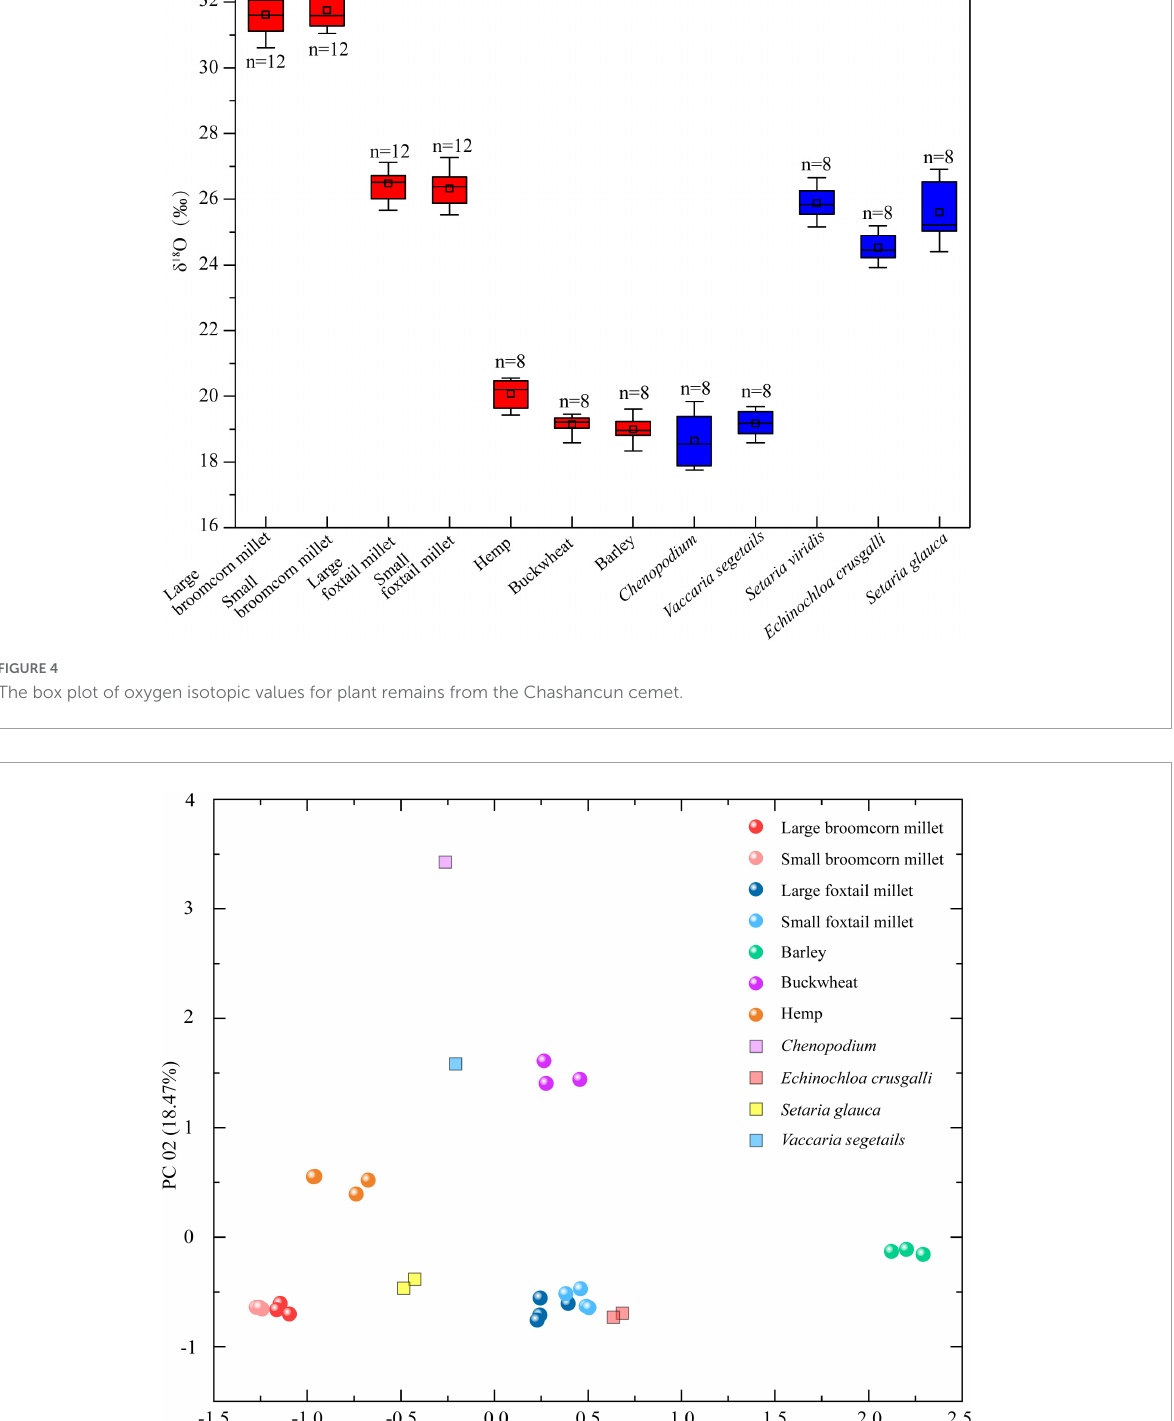
Frontiers in Plant